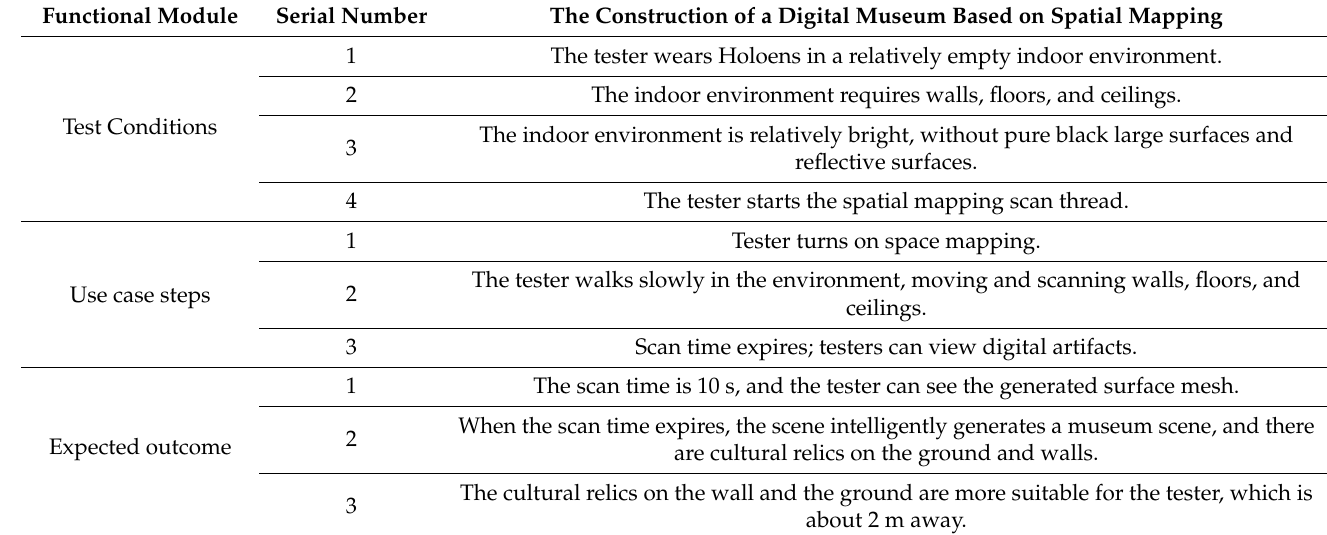
Table 1. Spatial mapping test